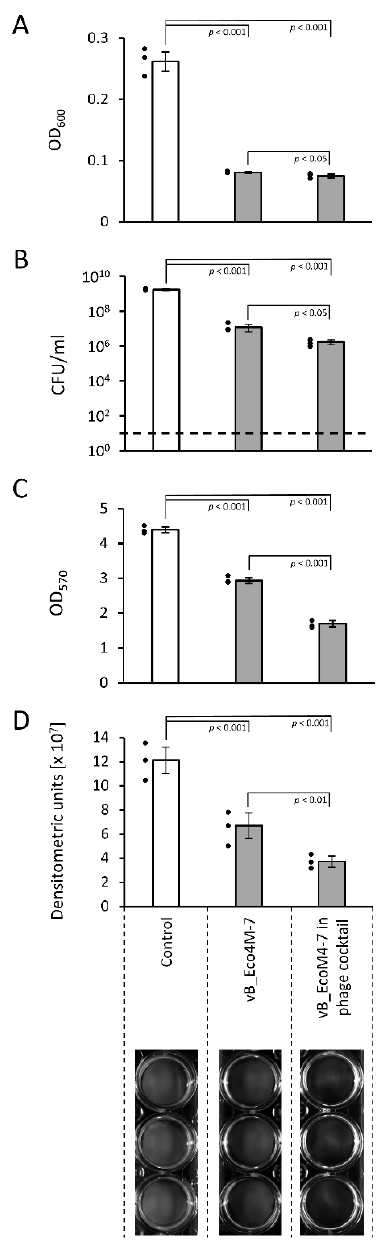
Figure 1. Bacterial biofilm density and viability of cells after a 6-h incubation with the vB_Eco4M-7 phage or the phage cocktail added at an MOI of 100 (10 10 PFU/well). The results are presented as the bacterial culture density measured at OD 600 ( A ), the number of survivors per ml of the suspension (CFU/mL) ( B) , the optical density values measured at wavelength 570 nm after biofilm staining with CV ( C ), or quantified densitometrically using UVITEC Allience Q9 Mini software ( D ). Signatures of the X-axis are the same for all panels and are placed at the bottom of the figure for clarity. The black dashed line represents the lower limit of detection ( C ). Mean values from three independent experiments are shown with error bars indicating SD. The black dots next to the columns denote datapoints from individual experiments. The statistical analyses were performed using the one-way ANOVA ( p value < 0.05 was considered statistically